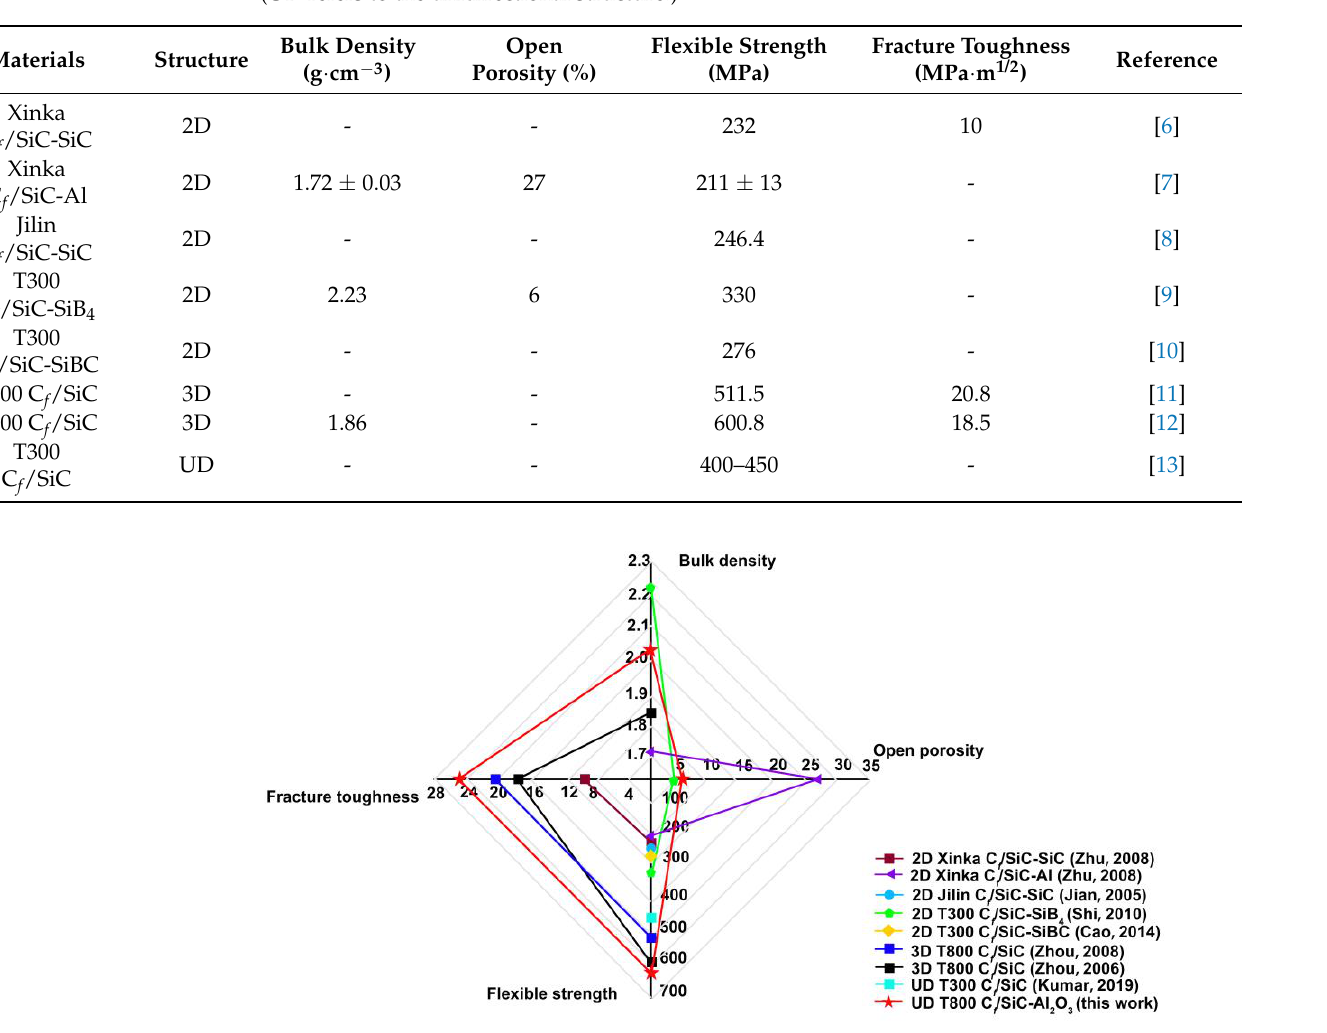
Figure 7. Comparison of general properties and mechanical properties between C f /SiC-Al 2 O 3 composites (this work) and other C f /SiC composites in previous works [6 – 13]. (UD refers to the unidirectional structure.)